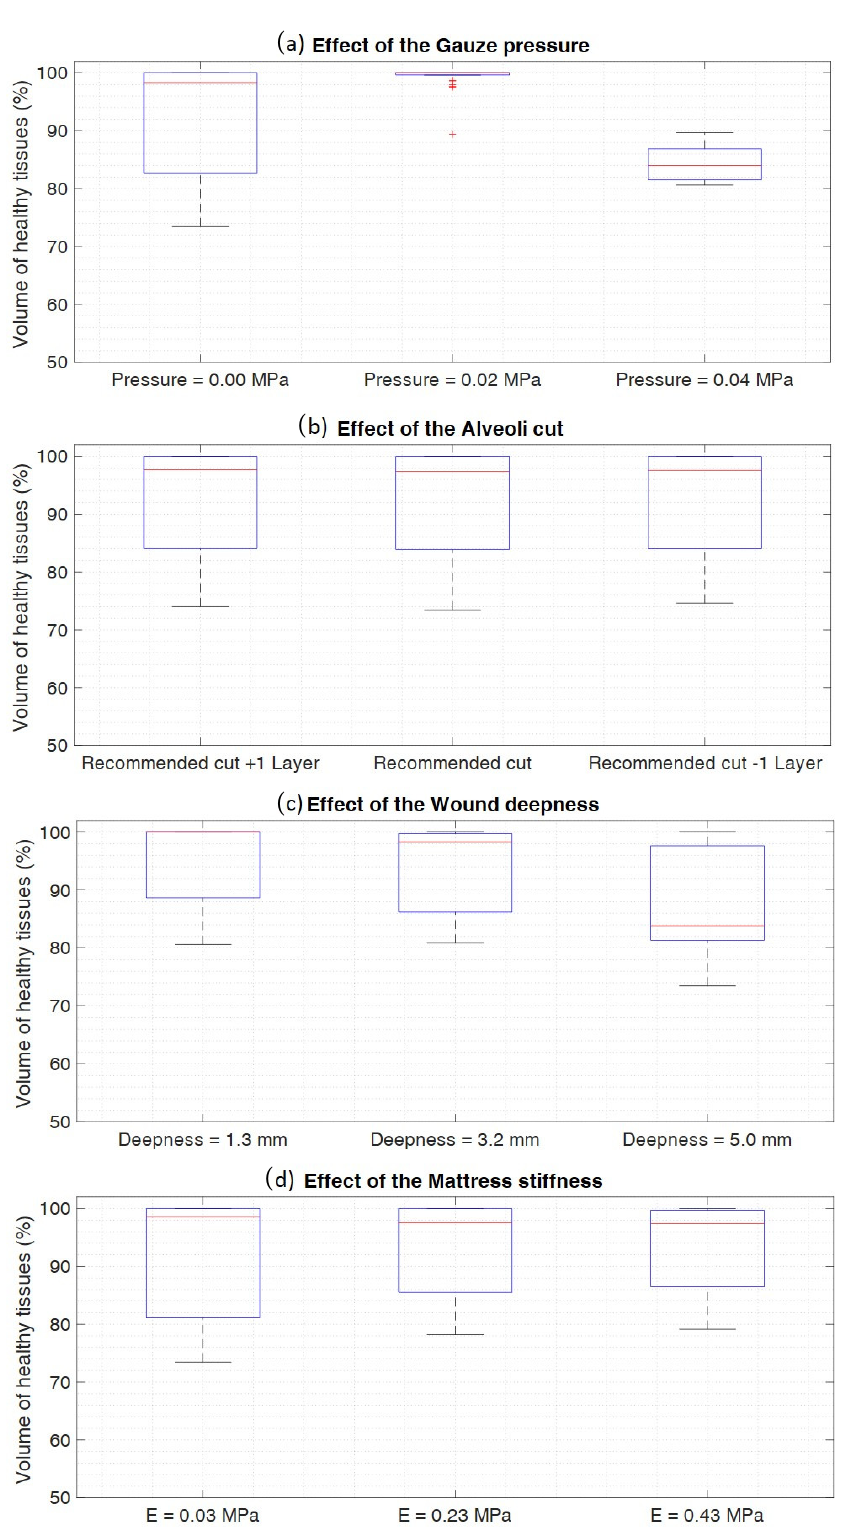
Figure 4. Effect of the four parameters on the volume of healthy tissues (i.e., tissues with strains lower than 0.3), with the other three parameters being set to their intermediary value. To illustrate the results, Green–Lagrange maximal shear strains in the ROI were plot- ted for some experiments in Figure 5.